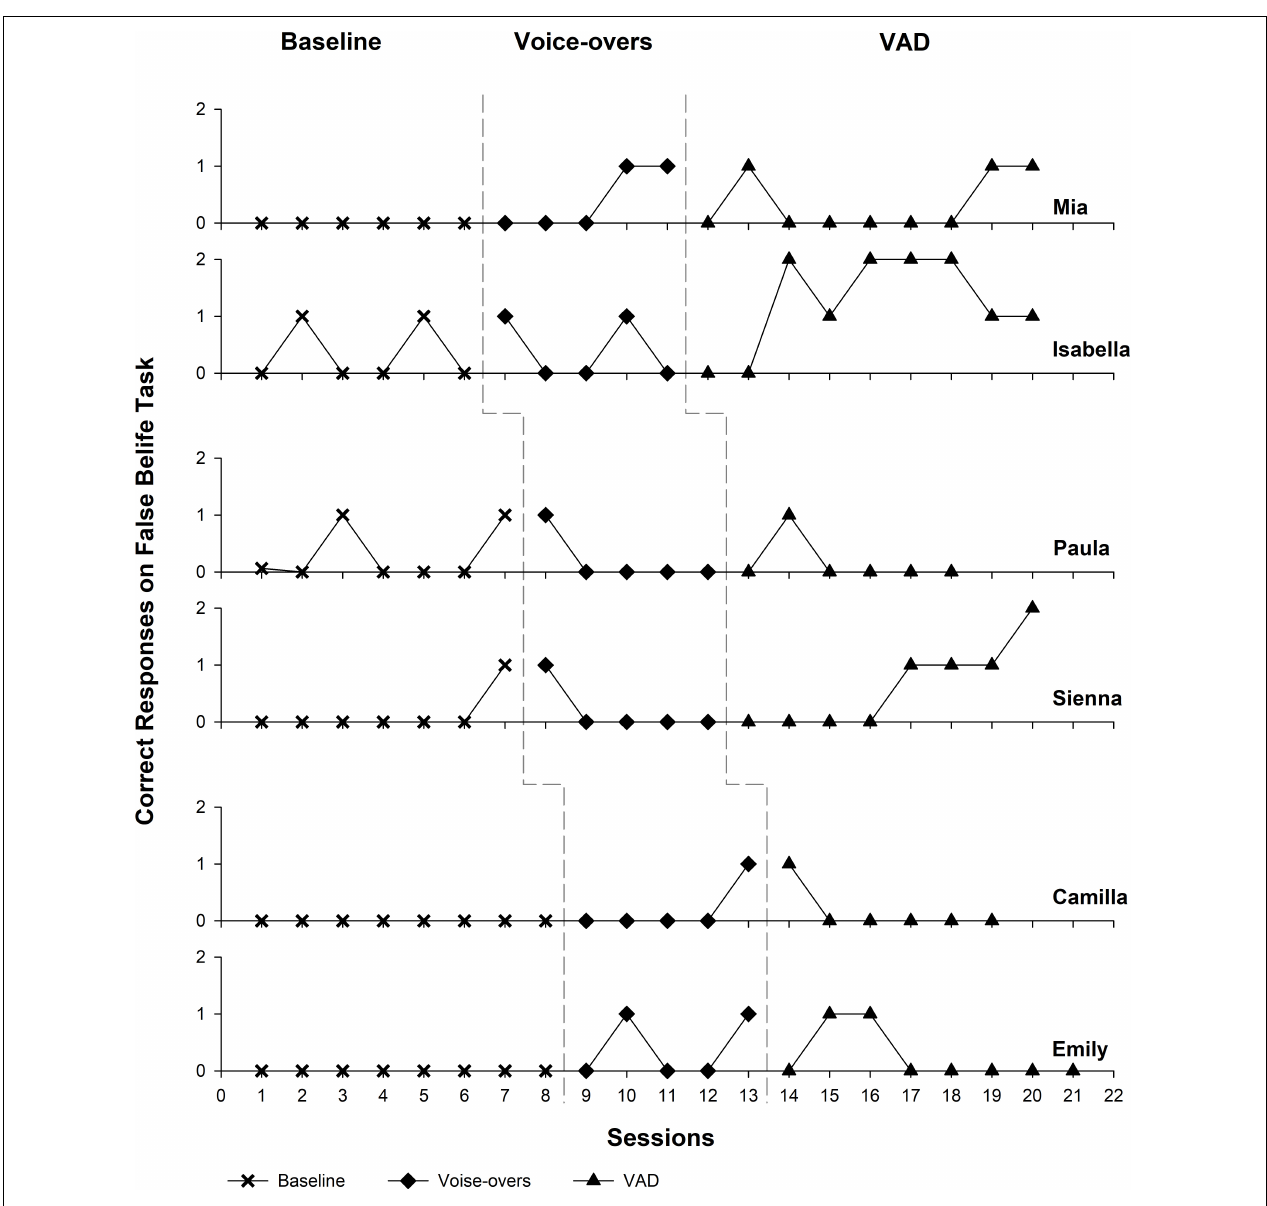
FIGURE 2 | Accuracy of responses to the two tasks in False Belief measure by participants across the research